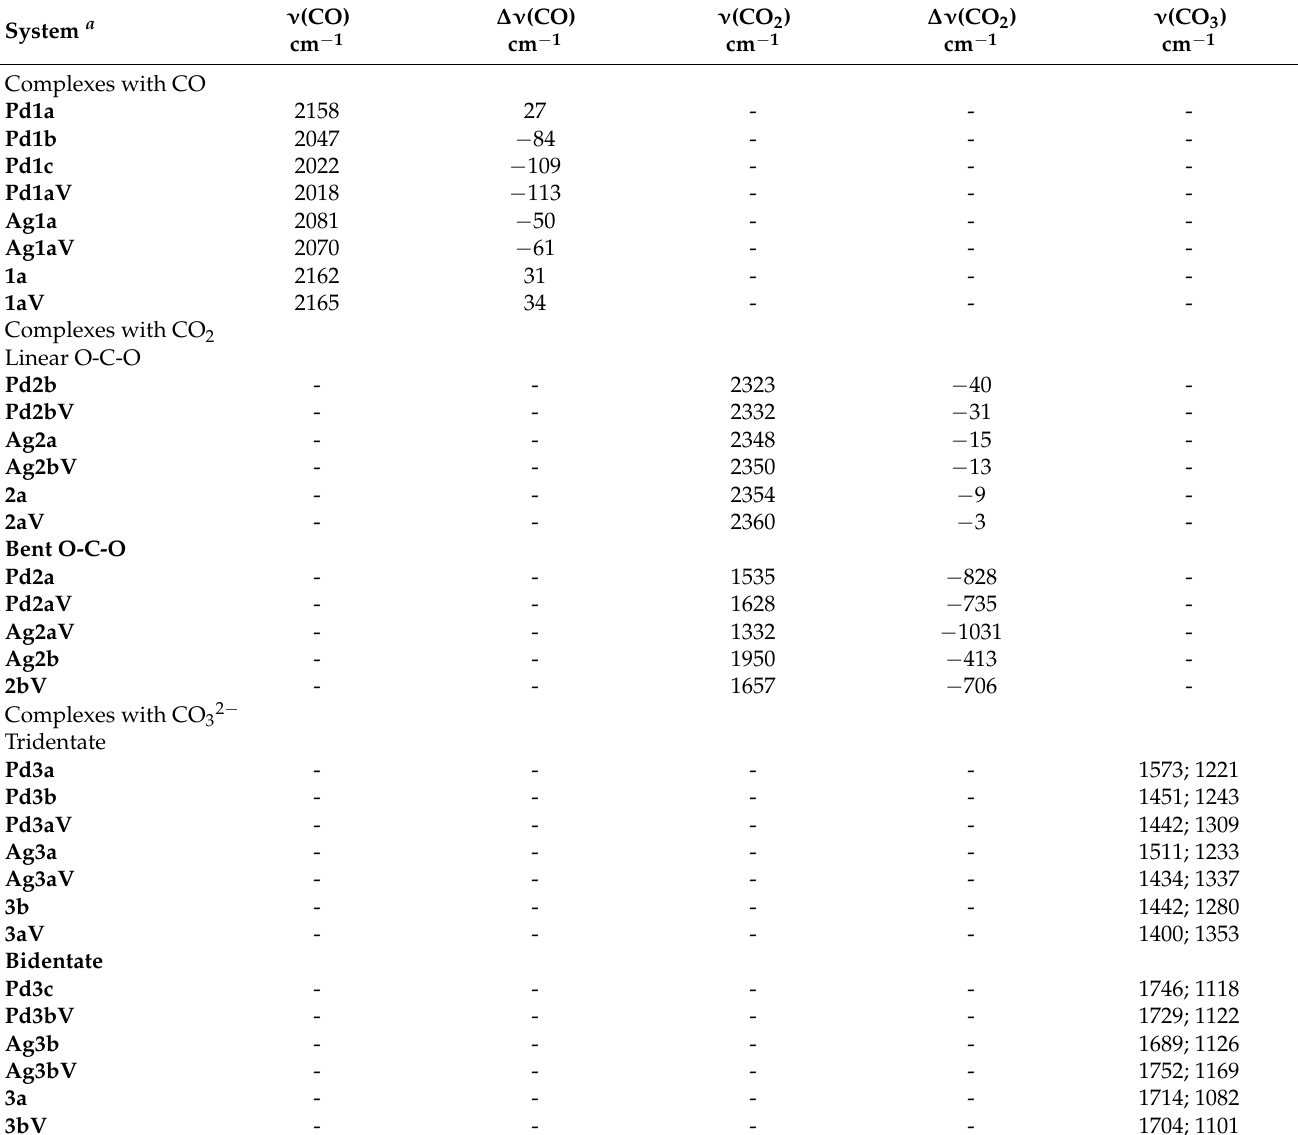
and Pd 2+ cations anchored to ceria [83]. Table 3. Calculated vibrational frequencies ν (CO), ν (CO 2 ) and ν (CO 3 ) for the systems depicted in Figures 2–4 along with the corresponding frequency shifts ∆ ν (CO) and ∆ ν (CO 2 ) with respect to calculated vibrational frequencies of free molecules CO ( ν (free CO) = 2131 cm − 1 ) and CO 2 ( ν asym (free CO 2 ) = 2363 cm − 1